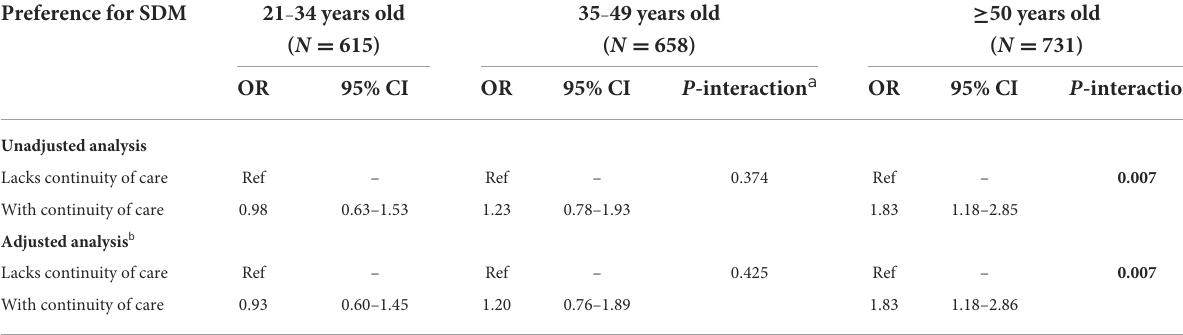
TABLE 2B Association between preference for shared decision-making on antibiotic prescribing and continuity of care, according to age group, N = 2004. Preference for